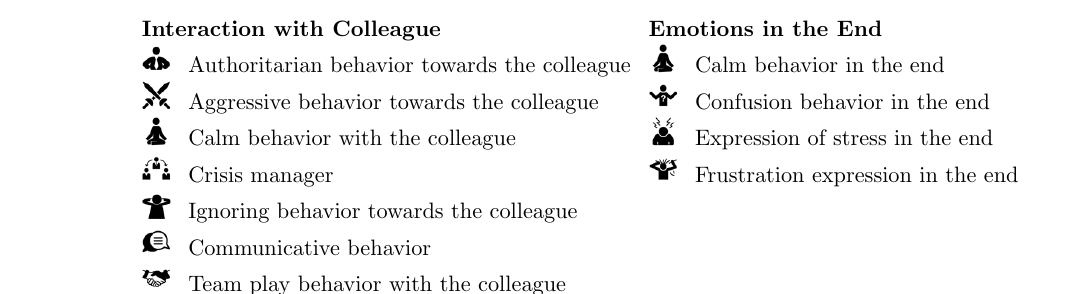
Table 2. This table presents the participants with their characteristic features in matters of human interaction, scepticism, medical measures, weighted received cue points, emotions, and ending